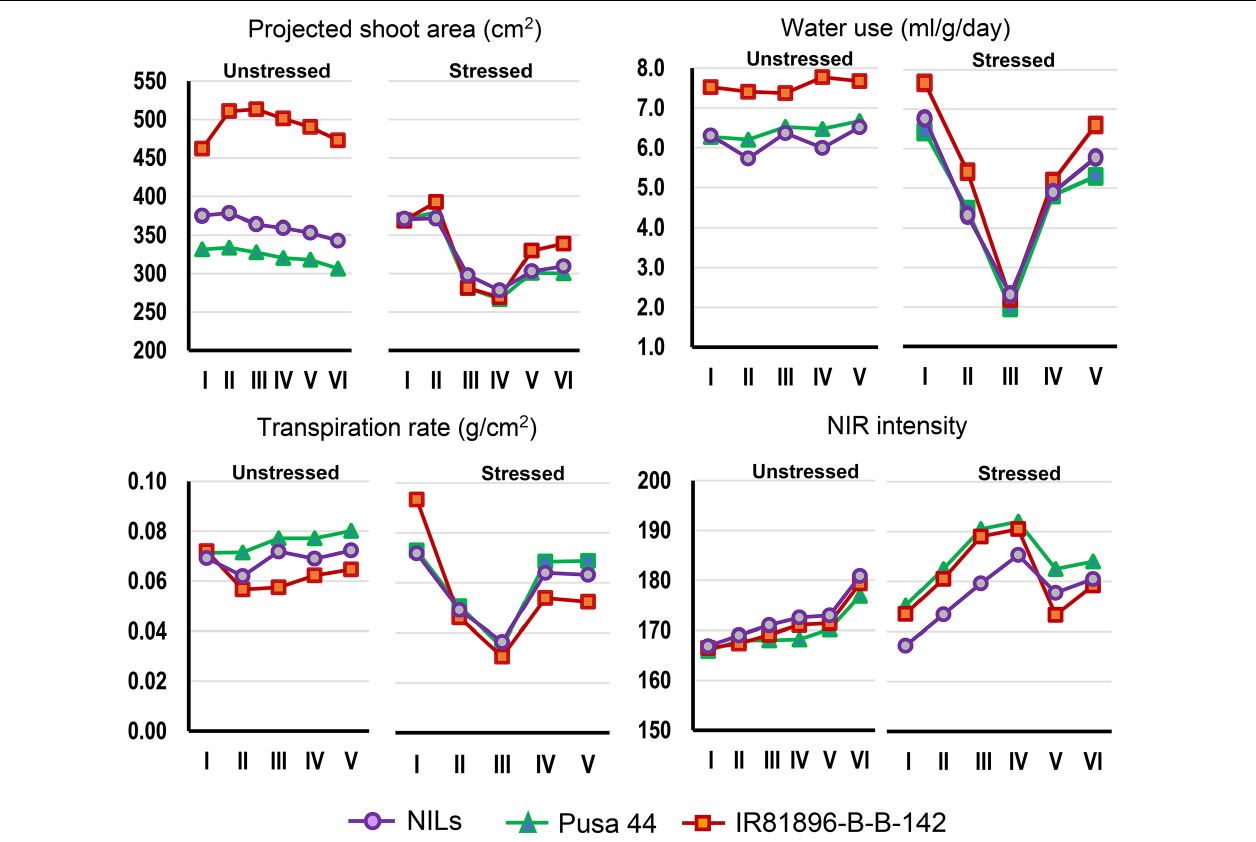
FIGURE 3 | Graphical comparison of the temporal response of genotypes under stressed and unstressed treatments for the four phenomics parameters. The overall trend indicated differential response under stress which was largely absent under unstressed